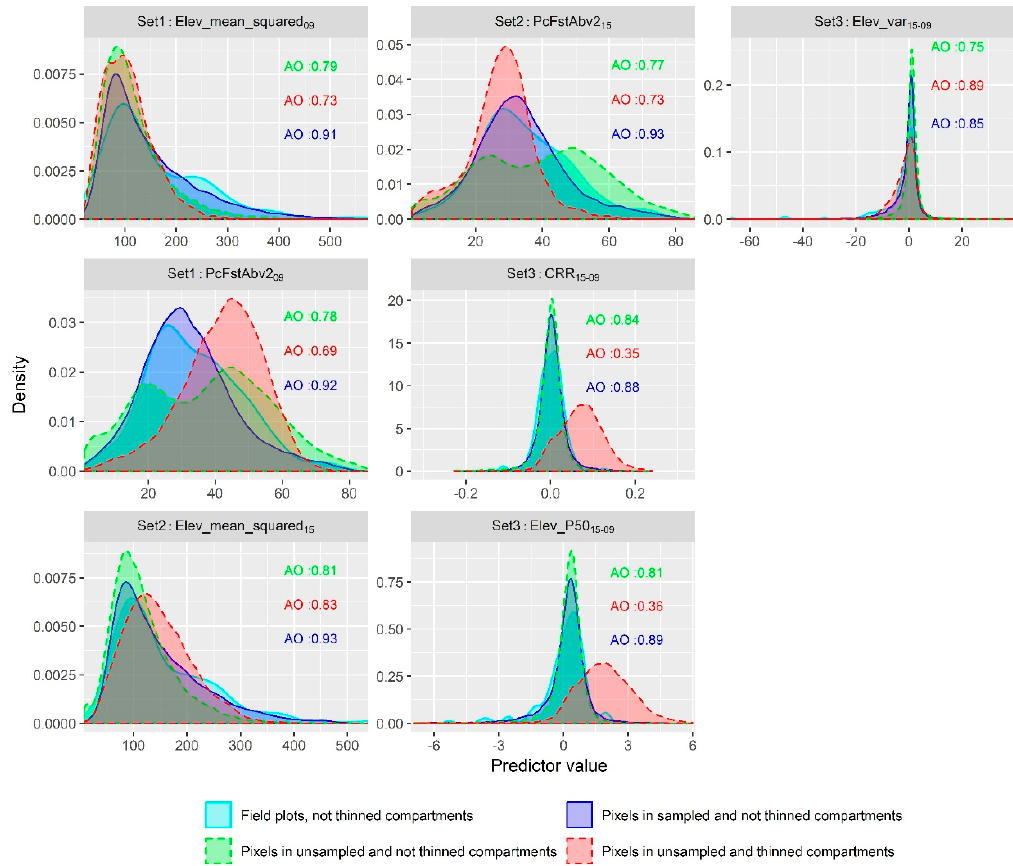
Figure A5. Comparison of density functions for the predictors in the models used to estimate changes in Biomass using the δ -modeling method and y -modeling method in field plots (light blue), sampled and not thinned stands (dark blue), unsampled and not thinned stands (light blue) and unsampled and thinned stands (red). For each group the area of overlap, AO, with the density function for the field plots (green) is provided for each predictor.